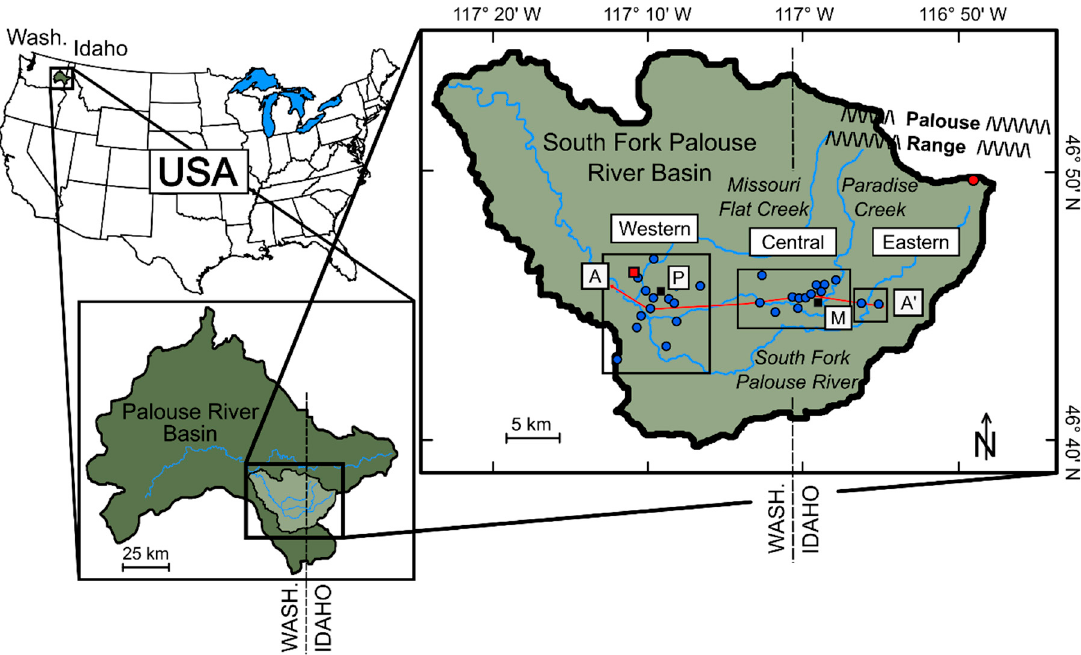
Figure 1. The South Fork Palouse River Basin of north central Idaho and eastern Washington (Wash.), USA. The South Fork Palouse River Basin is a subbasin in the Palouse River Basin. Included in the figure are the study’s well locations shown as blue circles, a U.S. Network for Isotopes in Precipitation (USNIP) station (WA24) shown as a red square, a high elevation snow collection site shown as a red circle, the location of Pullman, Washington (P) and Moscow, Idaho (M) and the lineament of a geologic cross-section, A ― A’ (Figure 2).